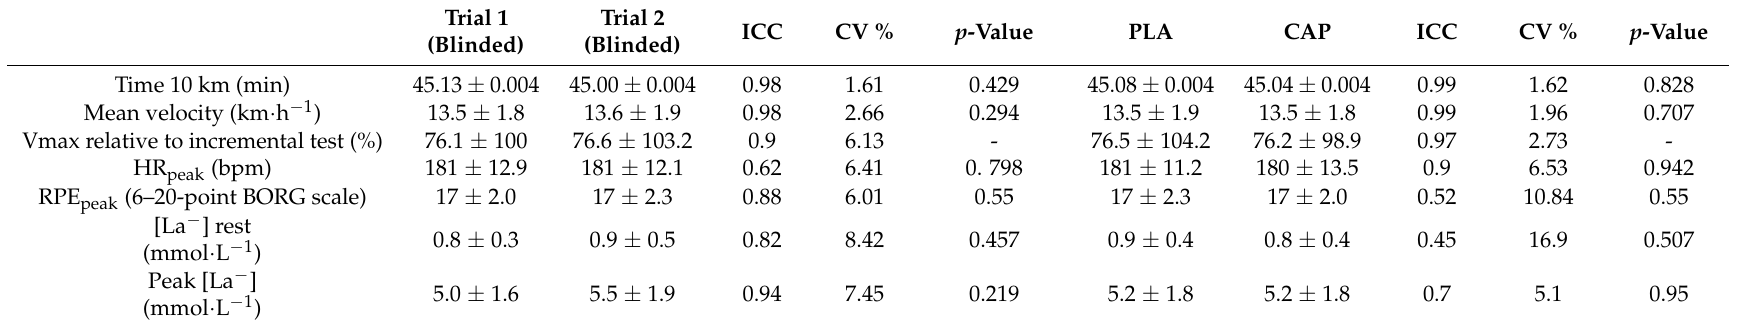
Table 3. Performance and physiological response in 10 km running test at capsiate (CAP) and placebo conditions ( n = 21).